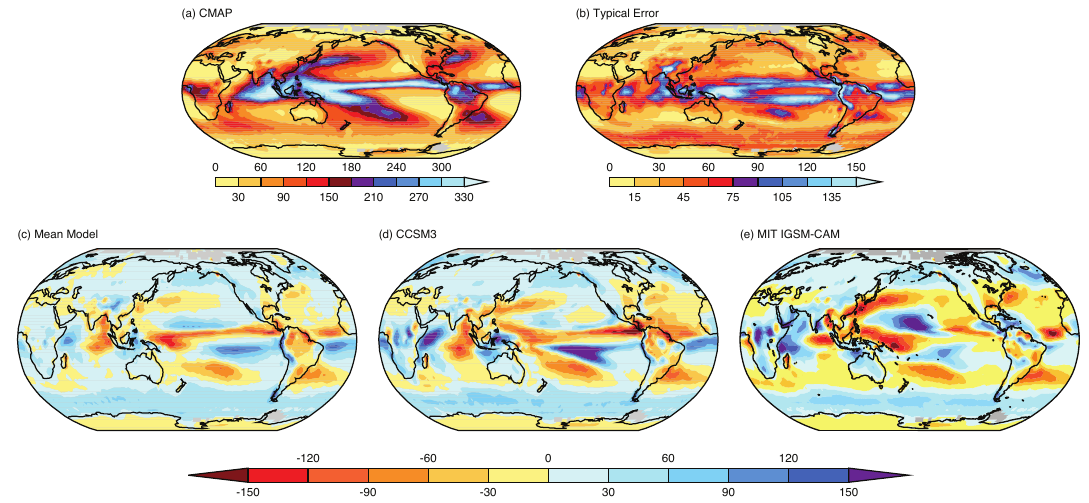
Fig. 8. (a) Observed annual-mean CMAP precipitation climatology for 1980–1999 (cm); (b) root-mean-square model error (cm), based on all available IPCC model simulations (i.e., square-root of the sum of the squares of individual model errors, divided by the number of models); (c) IPCC AR4 multi-model mean error (cm), simulated minus observed; (d) CCSM3 model error (cm), simulated minus observed; and (e) IGSM-CAM model error (cm), under median climate sensitivity, simulated minus observed. The model results are for the same period as the observations. Observations were not available in the gray regions. Adapted from Randall et al. (2007), Fig.